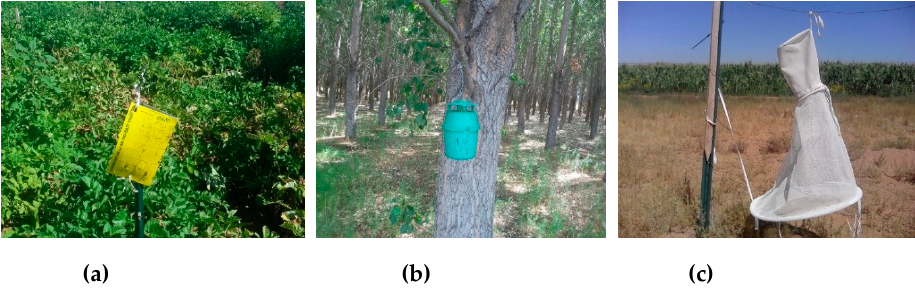
Figure 1. Average air temperature ( a ) and average air relative humidity during the study period ( b ).